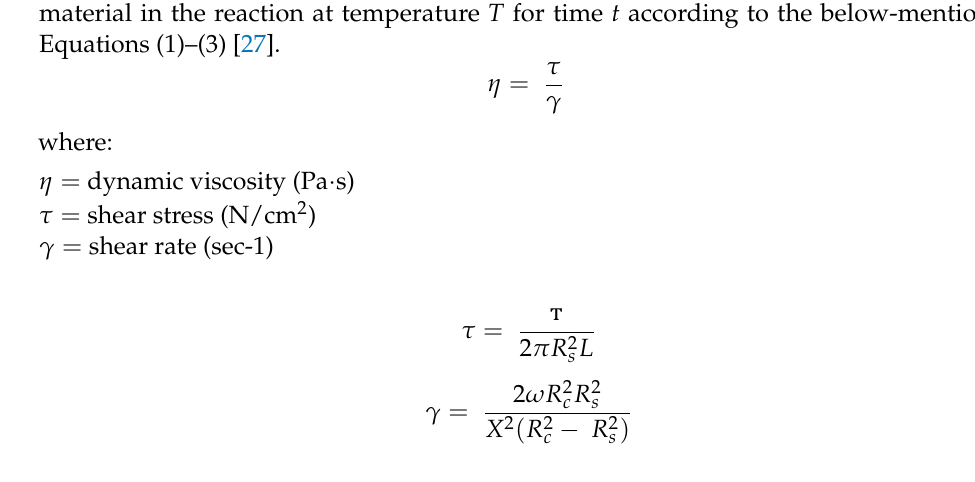
Figure 1. Torque variation of PP with reaction time by altering ( a ) BPO concentration and ( b ) MAH concentration. The recorded instantaneous torque (